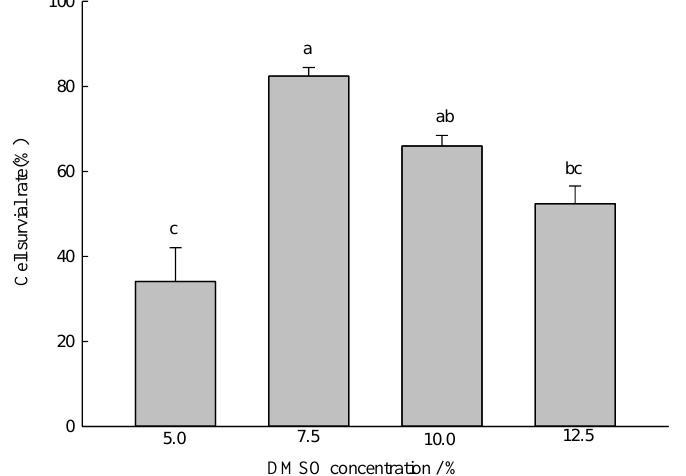
Figure 4. Effect of DMSO concentration on the cell survival percentage of F. mandshurica embryonic callus after cryopreservation by the slow cooling method. Note: Lowercase letters represent significant differences at p < 0.05.